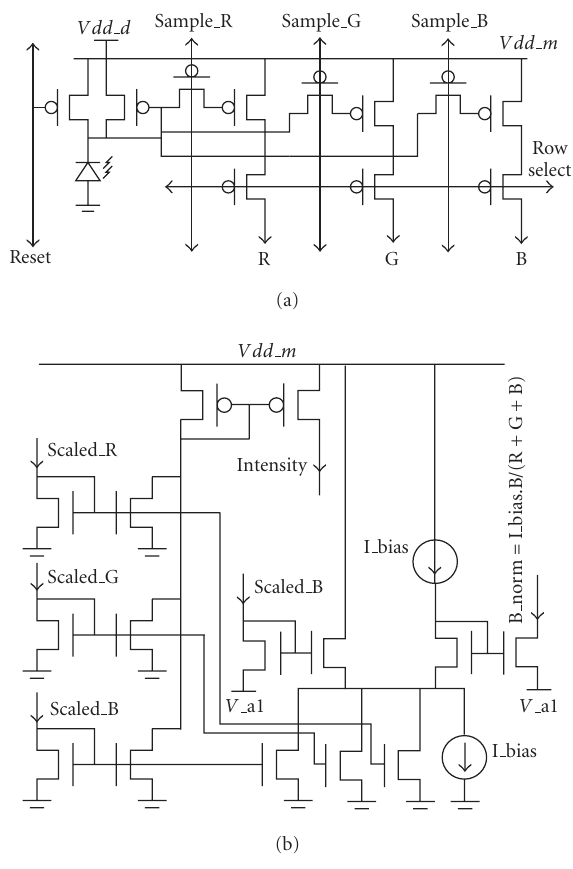
Figure 7: (a) Schematic of the pixel. (b) Schematic of the normal- ization